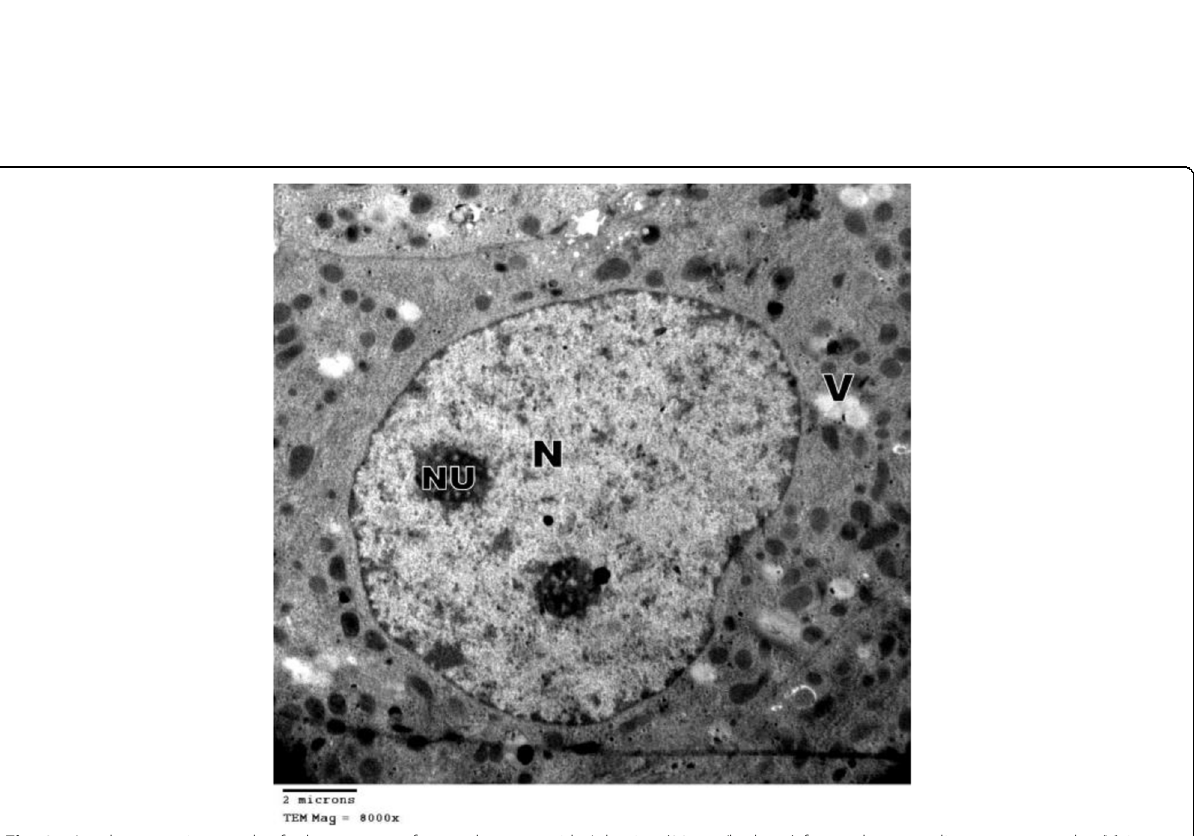
Fig. 24 An electron micrograph of a hepatocyte of treated mouse with Adamine (20 mg/kg b.wt.) for 15 days revealing many vacuoles (V) in cytoplasm and nucleus (N) has two nucleoli (Nu). (×